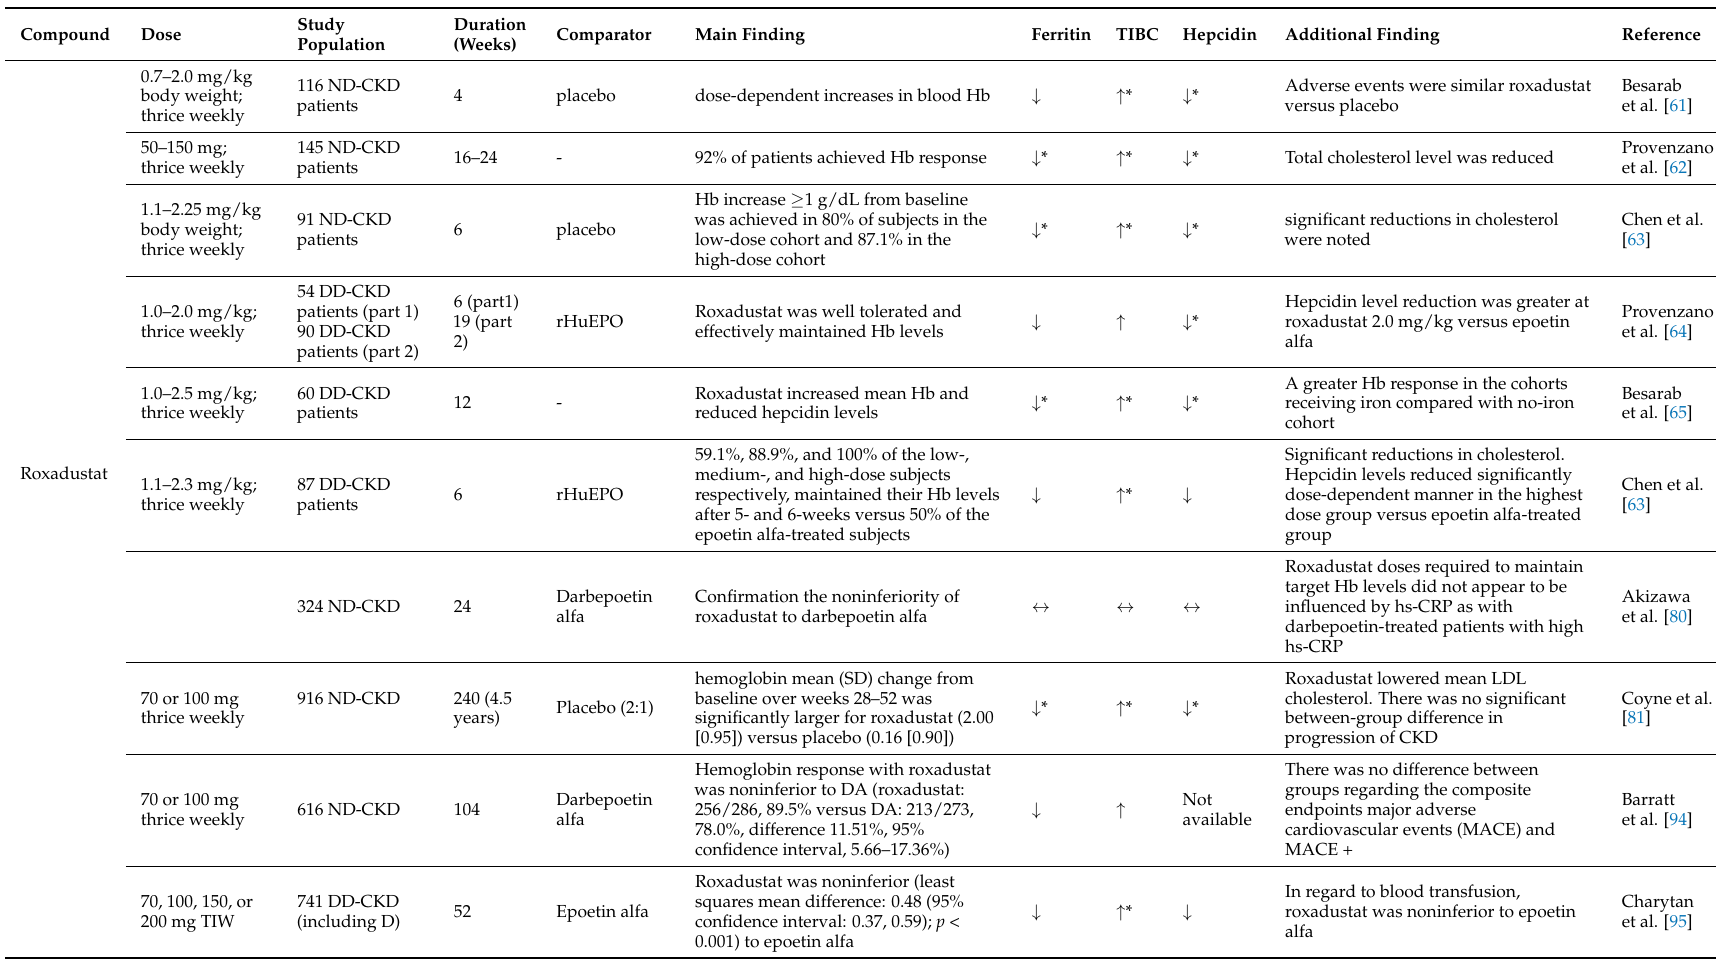
Table 1. HIF stabilizers—data on published peer-reviewed phase II studies in dialysis-dependent CKD and nondialysis-dependent CKD.